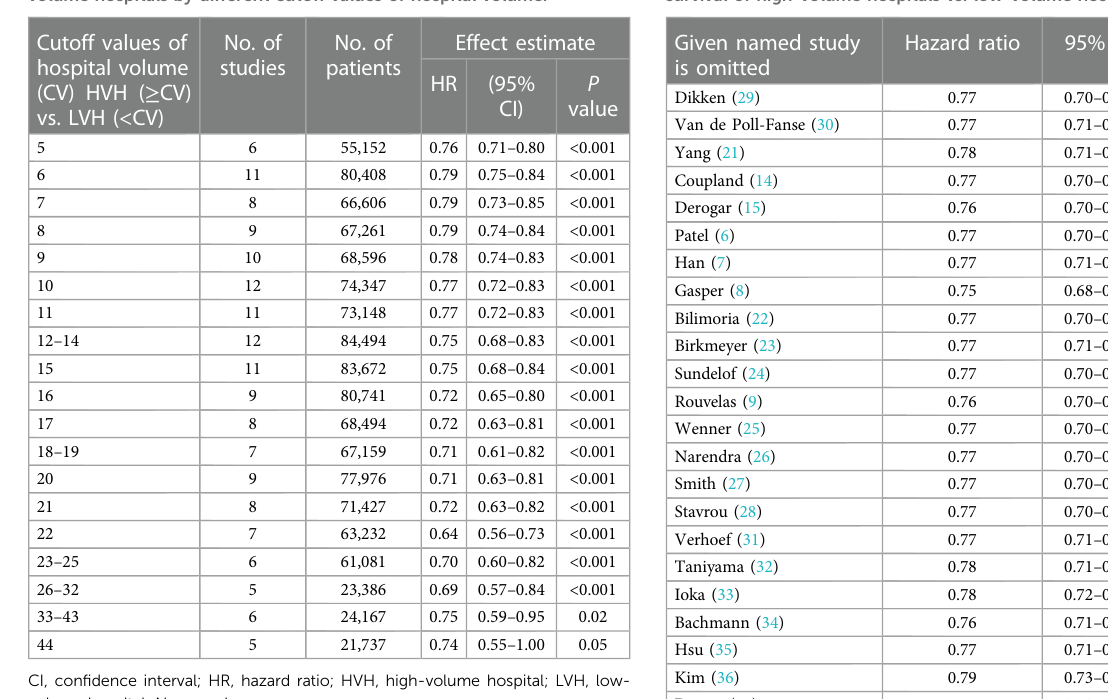
TABLE 5 Sensitivity analysis using leave-one-out method for overall survival of high-volume hospitals vs. low-volume